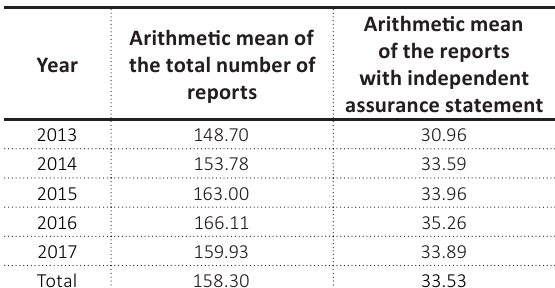
Table 5. Arithmetic mean of integrated reports in the EU